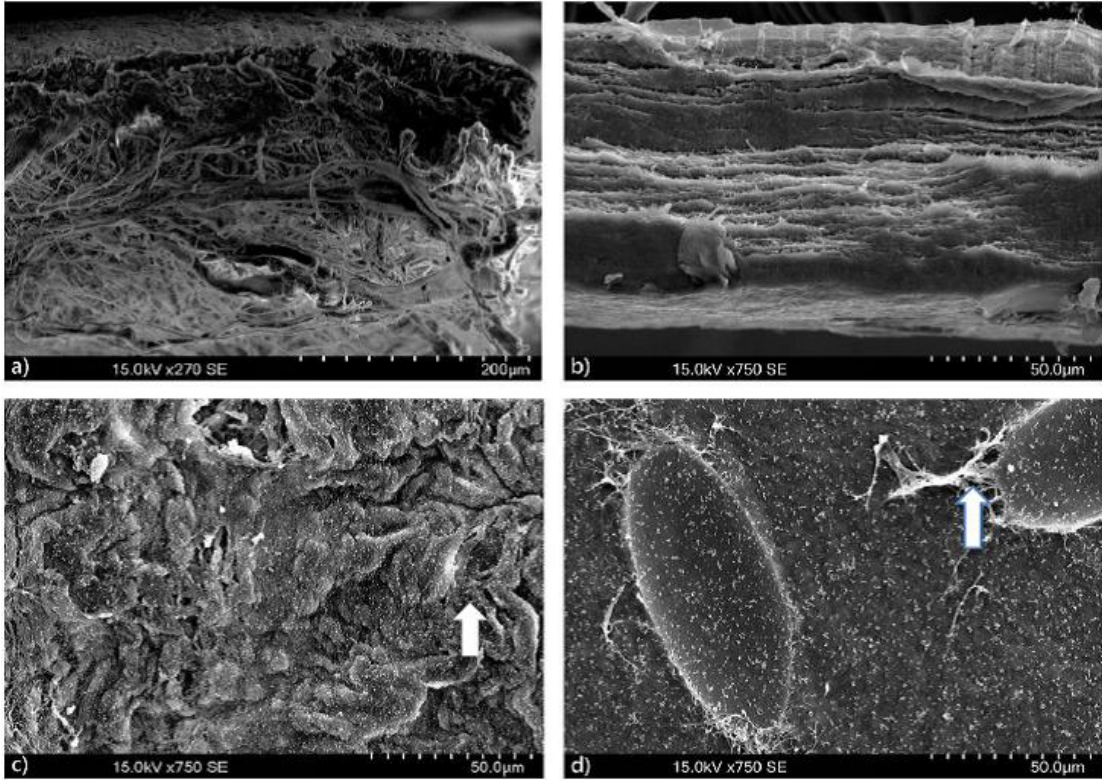
Figure 2. Scanning electron microscopy (SEM) showed: ( a ) Control membrane bilayer; ( b ) Test membrane monolayer; ( c ) Control membrane surface after 3 days with MG-63 cells in Dulbecco’s Modified Eagle’s Medium; ( d ) Test membrane surface after 3 days with MG-63 cells in Dulbecco’s Modified Eagle’s Medium.